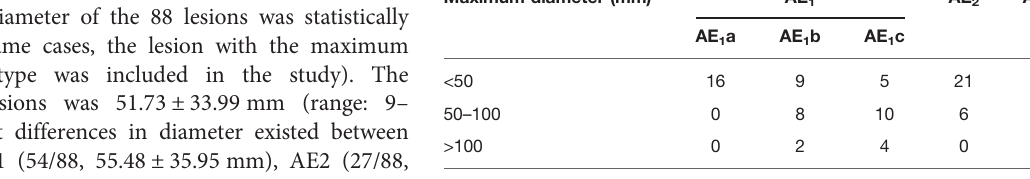
TABLE 2 | Maximum diameter and ultrasonographic classi fi cation of 88 HAE lesions (n/lesions). Maximum diameter